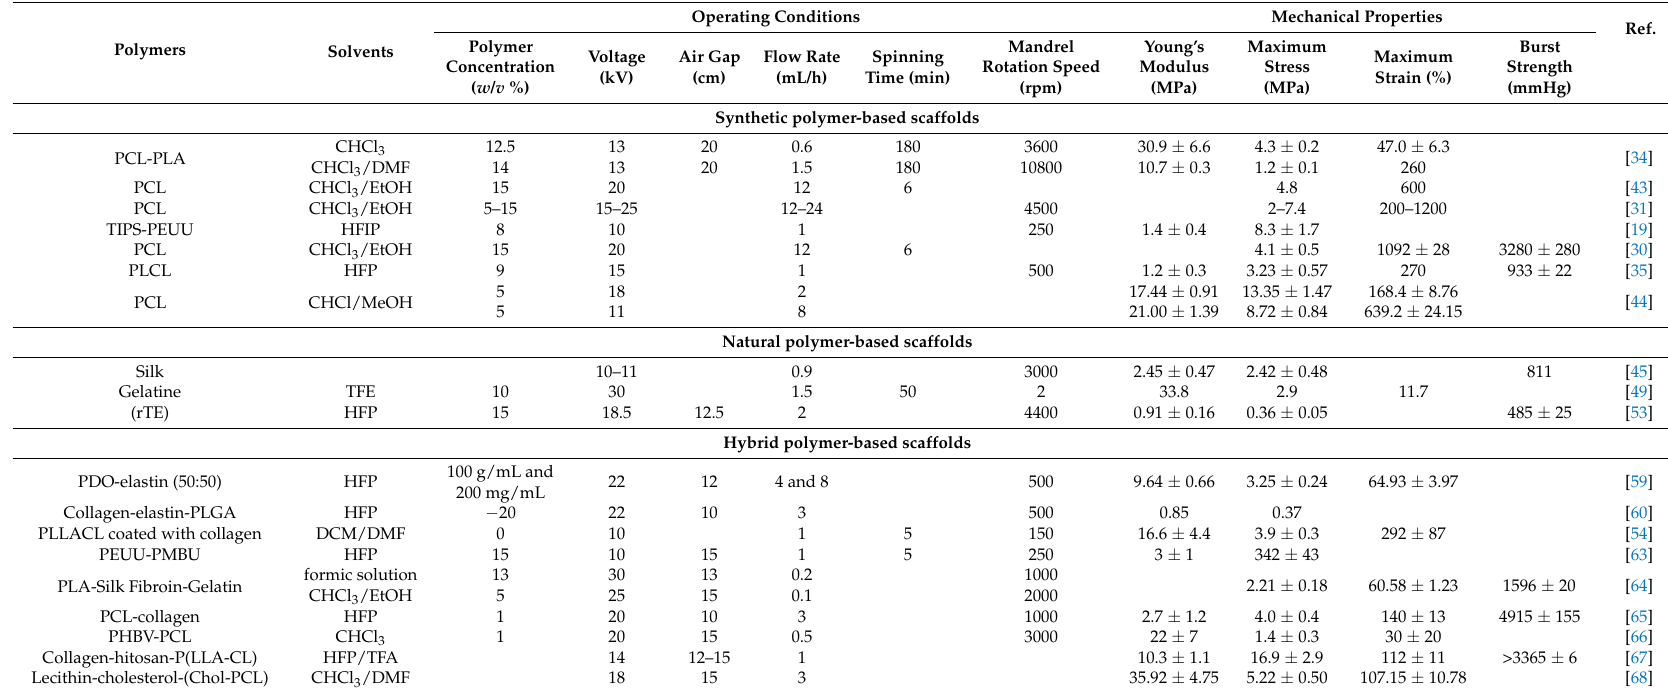
Table 2. Small diameter blood vessels prepared and their mechanical